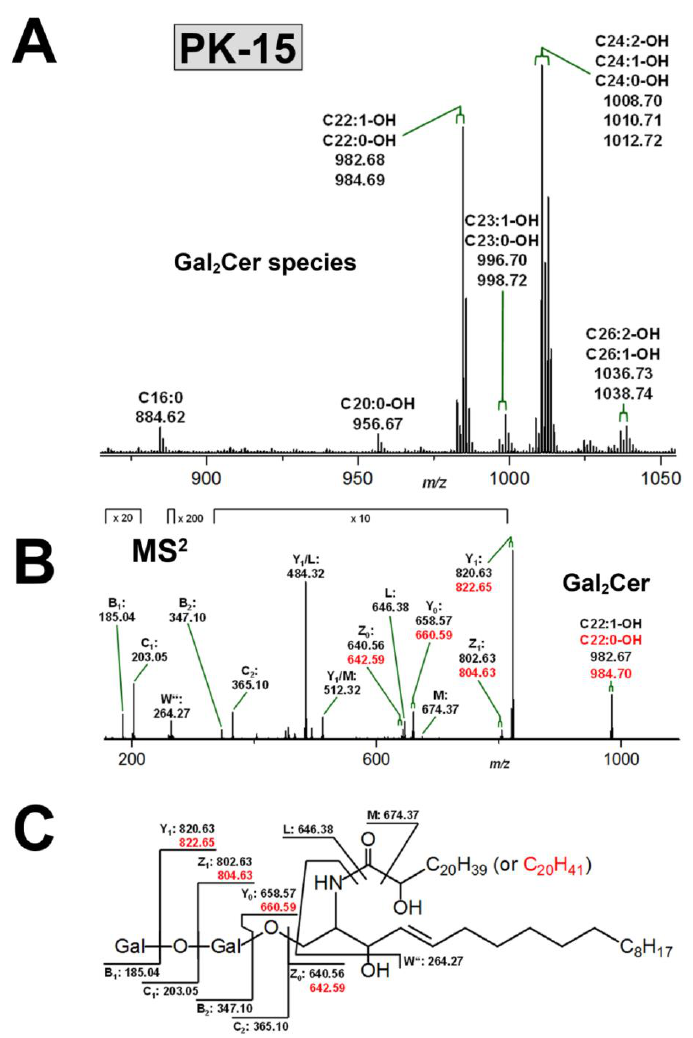
Figure 5. Overview MS 1 spectrum of Stx receptor Gal 2 Cer species ( A ) and MS 2 spectrum of selected Gal 2 Cer (d18:1, C22:1-OH) / Gal 2 Cer (d18:1, C22:0-OH) doublet ( B ) with the auxiliary fragmentation